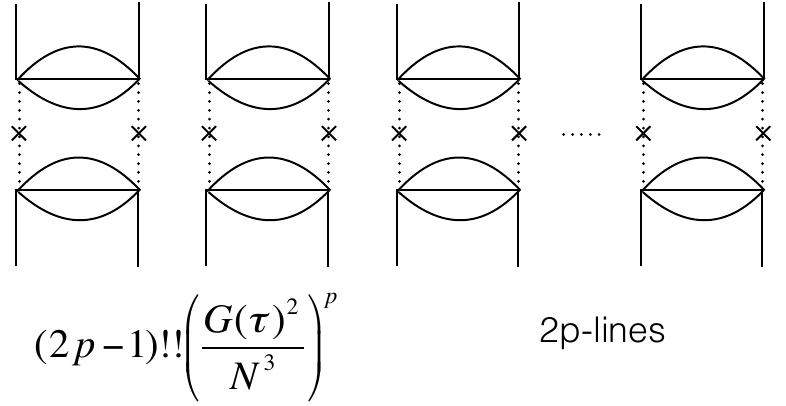
. Crossed dashed lines represent averaging 2 p